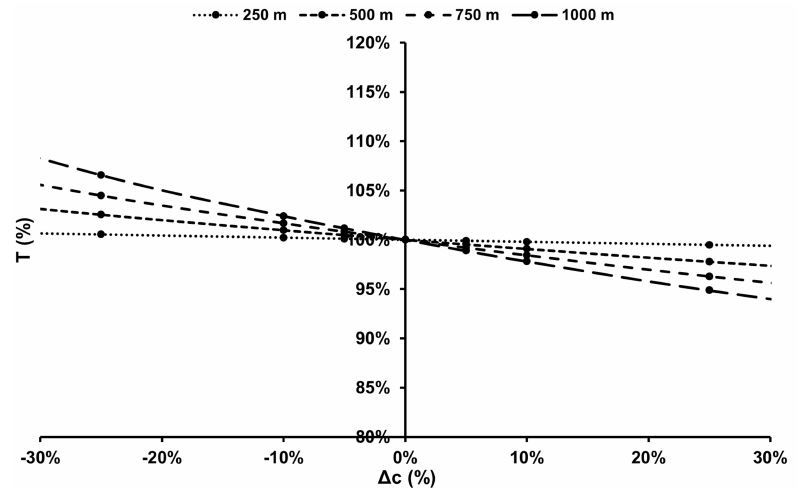
Figure 13. Change in the calculated run-time of the generic athlete as a function of change in the residual value c for distances from 250m to 1000m.